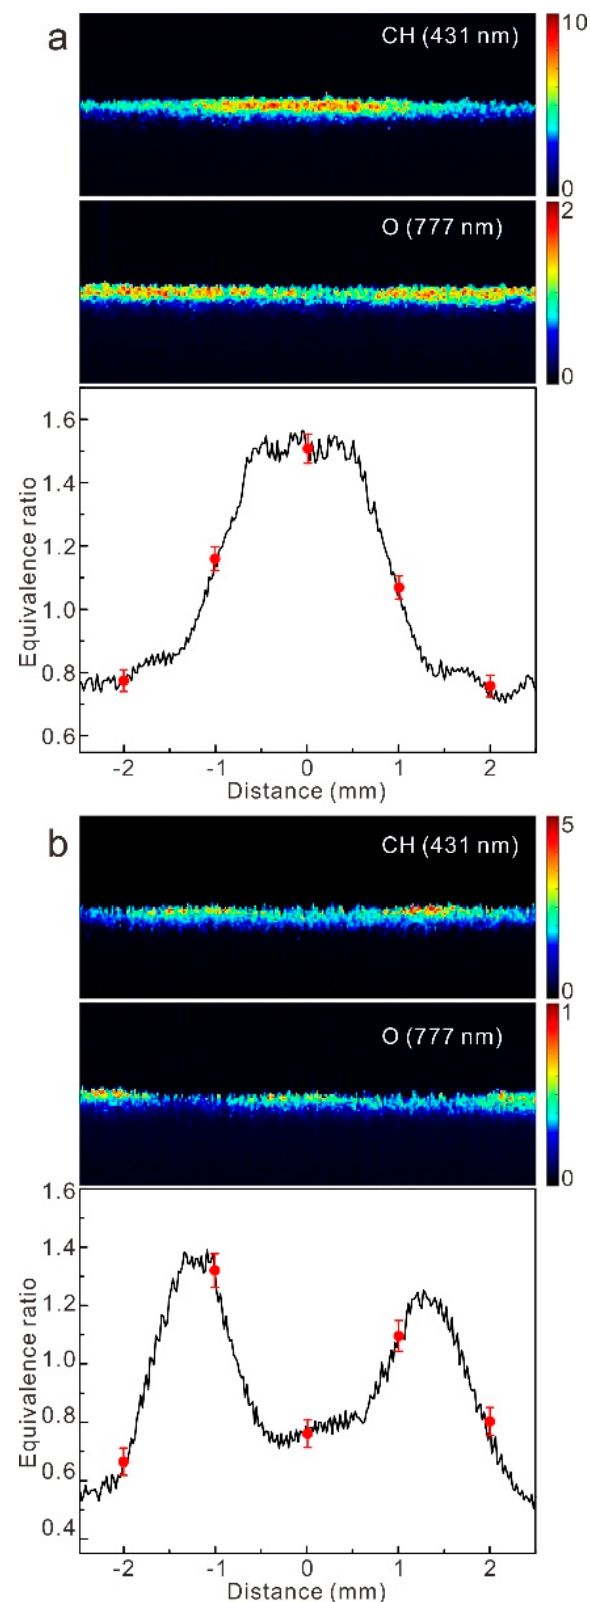
Figure 6. Single-shot images of femtosecond laser-induced plasma spectroscopy (FLIPS) in laminar ( a ) and turbulent ( b ) flow field with two intensified charge-coupled device (ICCD) cameras and two filters [113]. (© 2019 Optical Society of America ).